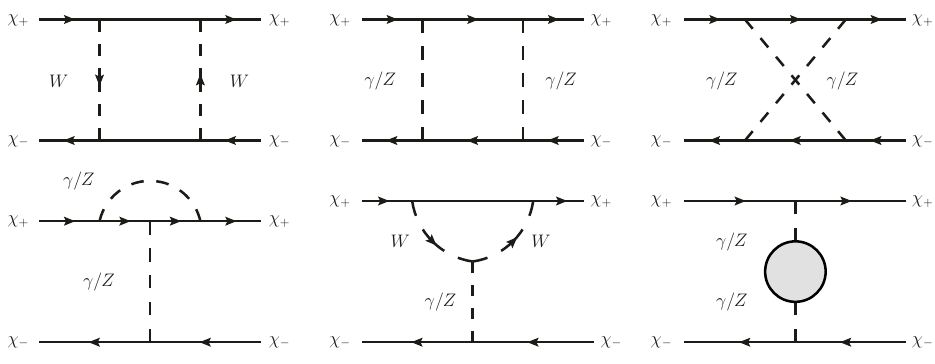
Figure 1 . Diagram topologies for the χ + χ − → χ + χ − channel excluding field renormalization, counterterm and tadpole topologies. Arrows on the lines indicate electric charge